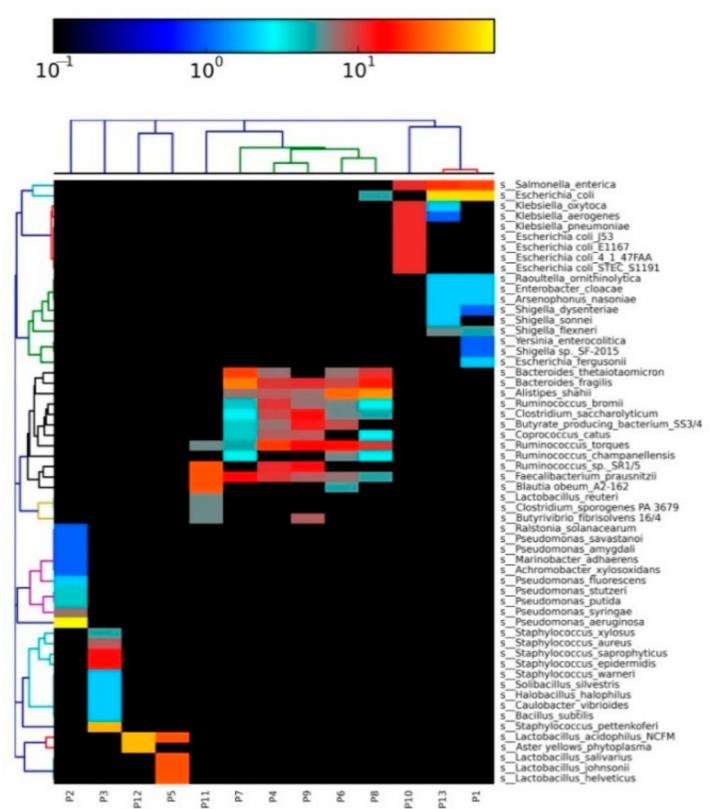
Figure 3. Heatmap showing the fecal microbiome profiling at the species level. All the bacterial species identified in the poultry fecal microbiome are hierarchically clustered using the Bray–Curtis dissimilarity matrix. P1 to P13 represents the sequenced shotgun metagenomic poultry samples ( n = 13). The relative abundance of various bacterial species is indicated in logarithmic values (base 10).